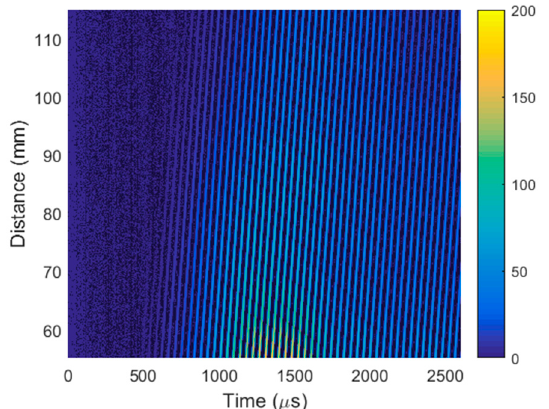
Figure 21. Reception of subsonic A 0 mode by virtual receiving array.